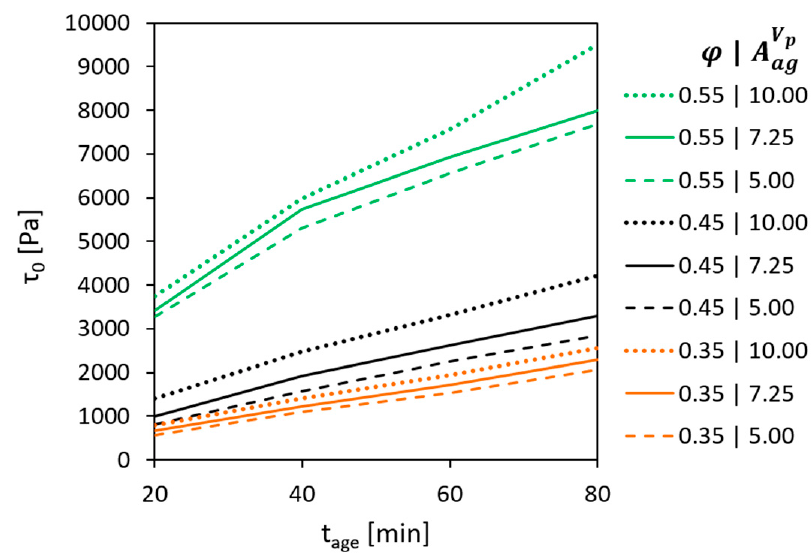
Figure 5. Development of static yield stress over age of concrete: effect of the volume fraction and the surface area of aggregates per unit volume of cement paste.